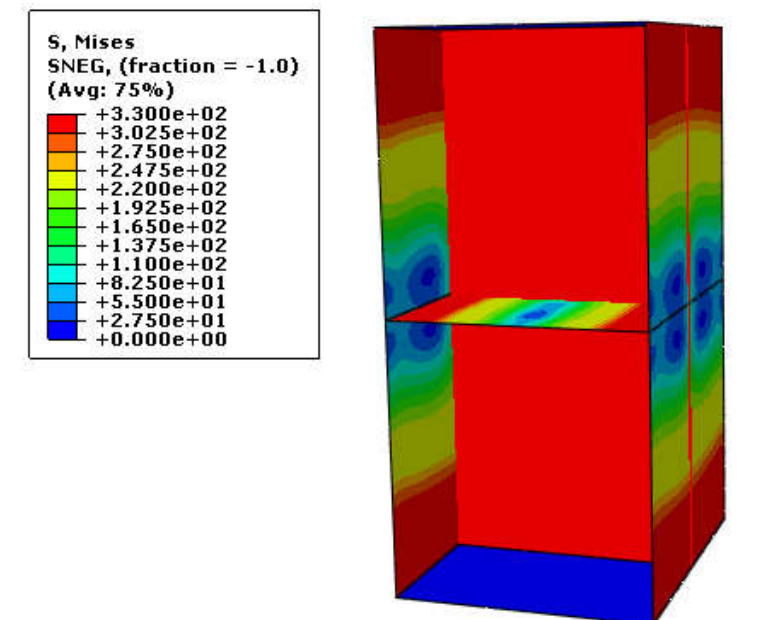
Figure 13. The stresses formed in sample BT150, 6 mm (kN/mm 2